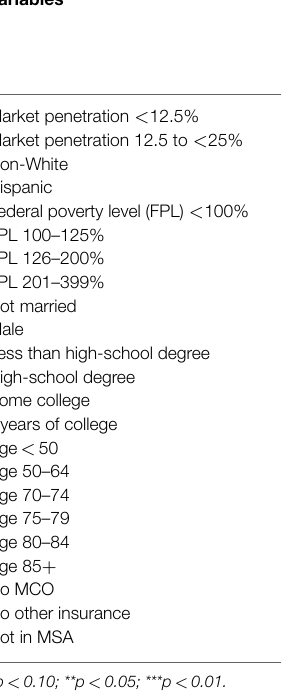
TABLE 2 | Odds ratios. a